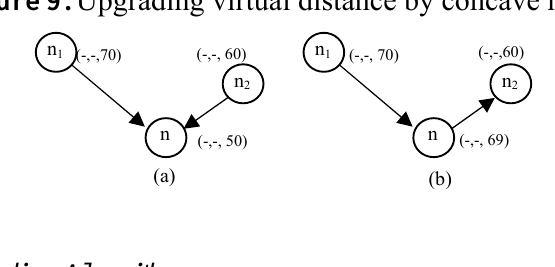
Figure 9. Upgrading virtual distance by concave